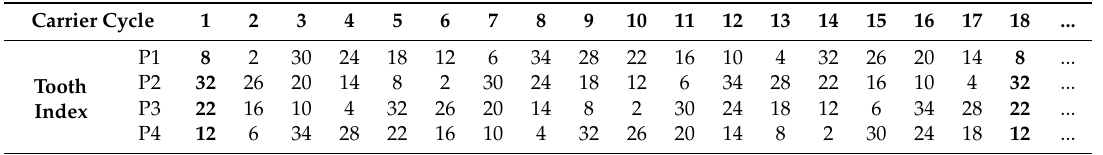
Table 2. Tooth Index of planet